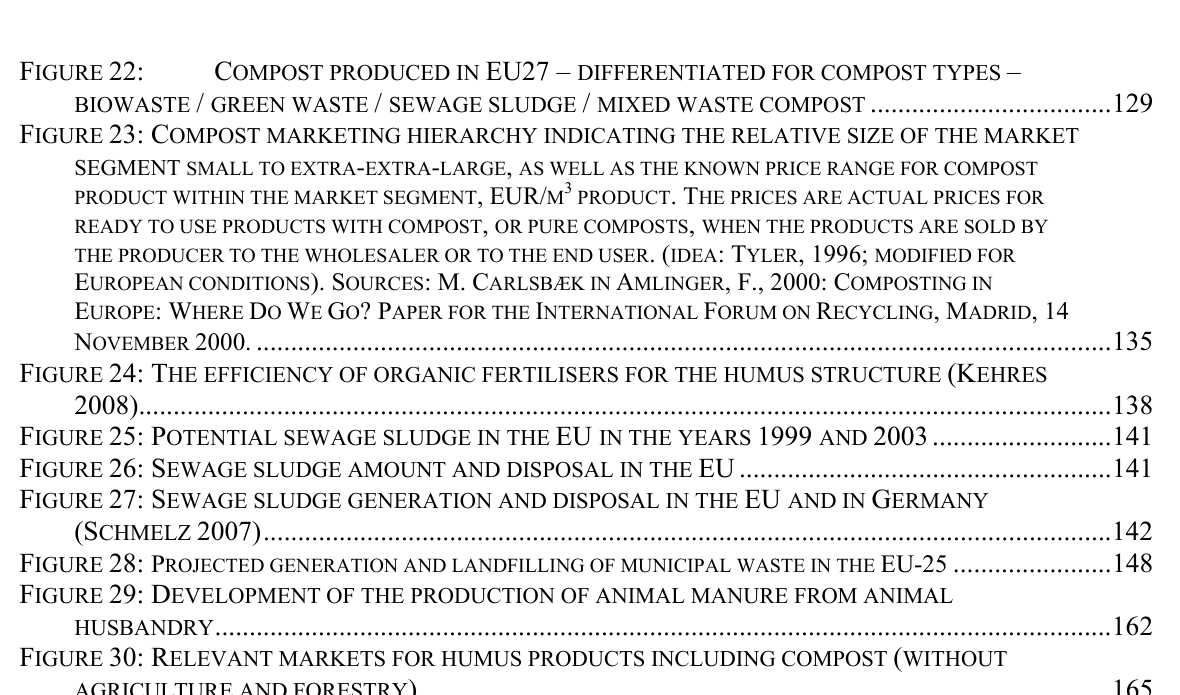
F IGURE 22: C OMPOST PRODUCED IN EU27 – DIFFERENTIATED FOR COMPOST TYPES – F IGURE 23: C OMPOST MARKETING HIERARCHY INDICATING THE RELATIVE SIZE OF THE MARKET SEGMENT SMALL TO EXTRA - EXTRA - LARGE , AS WELL AS THE KNOWN PRICE RANGE FOR COMPOST PRODUCT WITHIN THE MARKET SEGMENT , EUR/ M 3 PRODUCT . T HE PRICES ARE ACTUAL PRICES FOR READY TO USE PRODUCTS WITH COMPOST , OR PURE COMPOSTS , WHEN THE PRODUCTS ARE SOLD BY THE PRODUCER TO THE WHOLESALER OR TO THE END USER . ( IDEA : T YLER , 1996; MODIFIED FOR E UROPEAN CONDITIONS ). S OURCES : M. C ARLSBÆK IN A MLINGER , F., 2000: C OMPOSTING IN E UROPE : W HERE D O W E G O ? P APER FOR THE I NTERNATIONAL F ORUM ON R ECYCLING , M ADRID , 14 F IGURE 24: T HE EFFICIENCY OF ORGANIC FERTILISERS FOR THE HUMUS STRUCTURE (K EHRES F IGURE 25: P OTENTIAL SEWAGE SLUDGE IN THE EU IN THE YEARS 1999 AND 2003 ..........................141 F IGURE 26: S EWAGE SLUDGE AMOUNT AND DISPOSAL IN THE EU ......................................................141 F IGURE 27: S EWAGE SLUDGE GENERATION AND DISPOSAL IN THE EU AND IN G ERMANY F IGURE 28: P ROJECTED GENERATION AND LANDFILLING OF MUNICIPAL WASTE IN THE EU-25 .......................148 F IGURE 29: D EVELOPMENT OF THE PRODUCTION OF ANIMAL MANURE FROM ANIMAL F IGURE 30: R ELEVANT MARKETS FOR HUMUS PRODUCTS INCLUDING COMPOST (